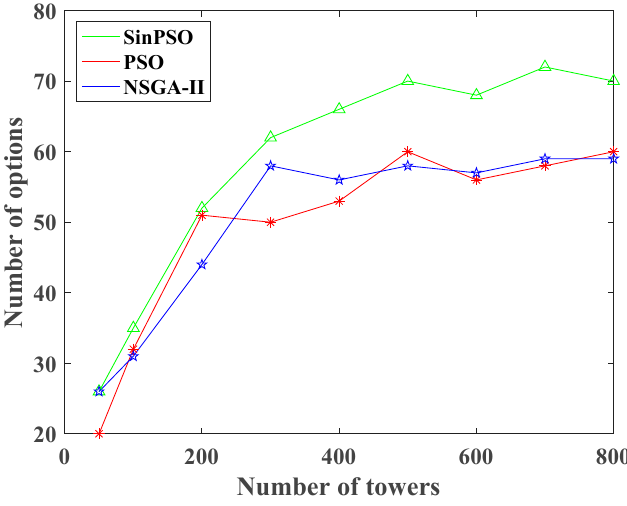
Figure 10. The result of algorithm diversity.